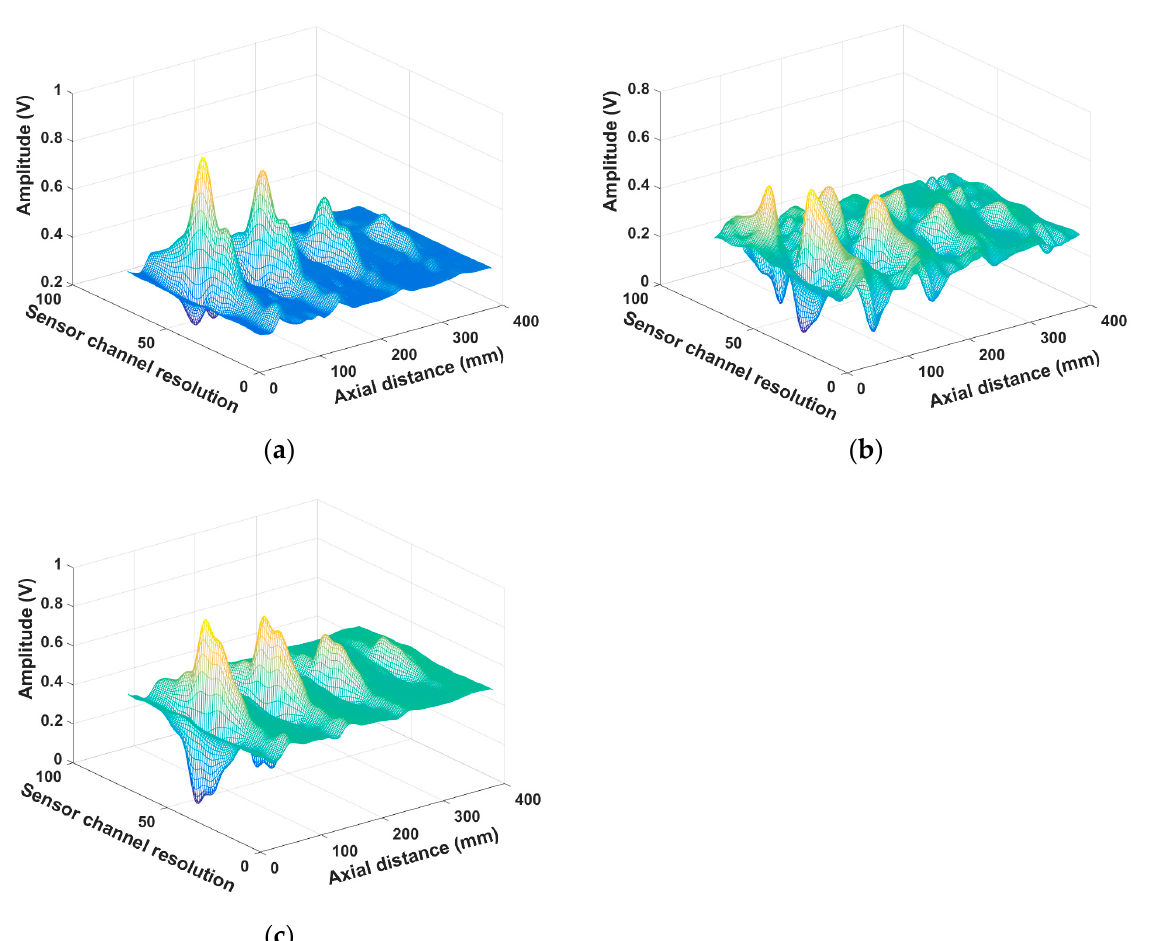
Figure 7. 3D magnetic leakage after noise reduction in channel 8.